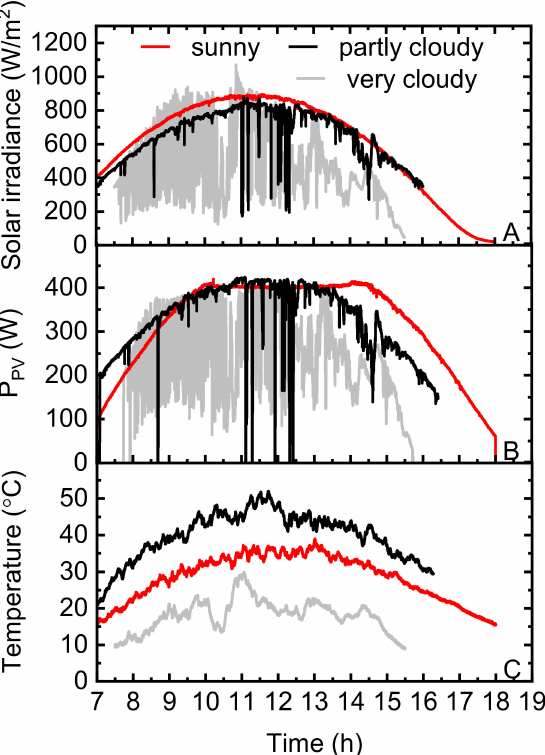
Figure 2. Variations of the amount of sunlight (plotted as ( A ): solar irradiance, ( B ): PV power and ( C ): temperature) as a function of time on different “solar days”, illustrating a “sunny day”, “partly cloudy day” and “very cloudy day”. Data were taken from the KIT Solar Park on 5 May 2016, 26 May 2016 and 13 Oct 2016,